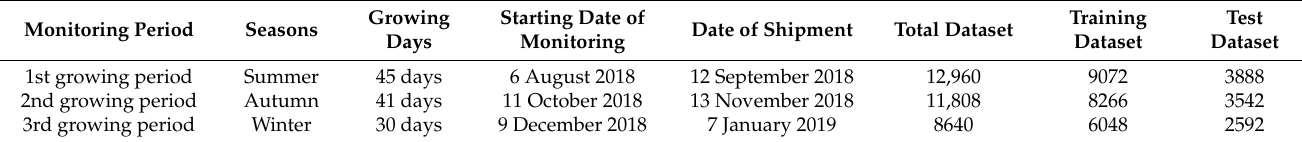
Table 2. Date according to growing period during the experimental